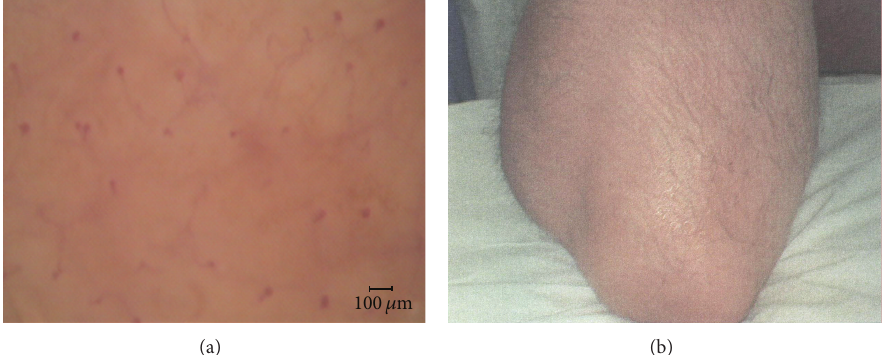
Figure 2: Capillaroscopic image (a) of the centre of the resolved psoriatic plaque (b) at T3 in the same patient of Figure 1.